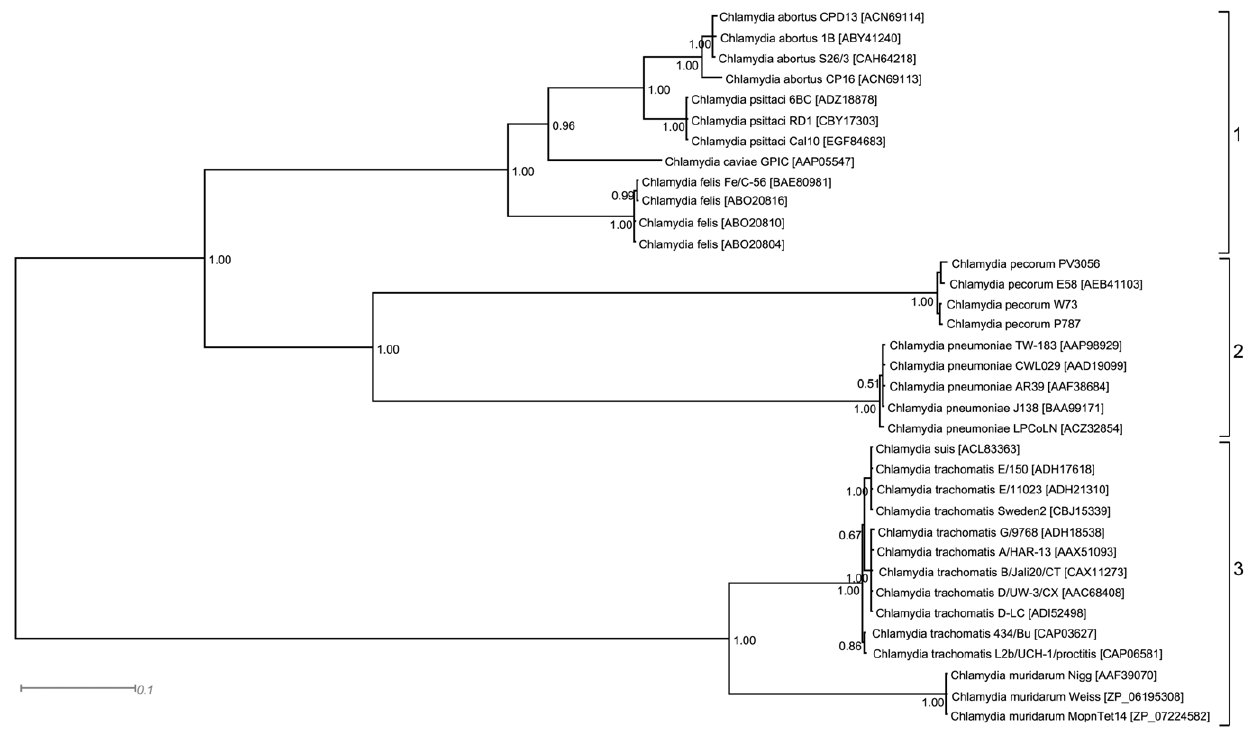
Figure 4. Bayesian dendrogram showing evolutionary relatedness of PmpD amino acid sequences originating from the nine Chlamydia species. Accession numbers of the amino acid sequences are indicated to the right of the strain name. The posterior probability of discrete groupings is indicated by the number at the node. The 3 PmpD clusters (cluster 1: C. abortus , C. psittaci , C. caviae and C. felis ; cluster 2: C. pneumoniae and C. pecorum ; and cluster 3: C. trachomatis , C. suis and C. muridarum ) that were identified in this study are indicated to the right of the dendrogram. Figure S1 Western blot demonstrating the solubility of the Pmp18D N-terminal passenger domain in 2% sarkosyl (using the Mid-Pmp18D antibody). Lane 1 Whole C. abortus Elementary bodies (EBs); Lane 2 Soluble fraction after treatment of whole EBs with 2% sarkosyl; Lane 3 Soluble fraction after treatment of sarkosyl insoluble pellet with 1mM DTT/2% Sarkosyl; Lane 4 Sarkosyl insoluble material. (PDF)